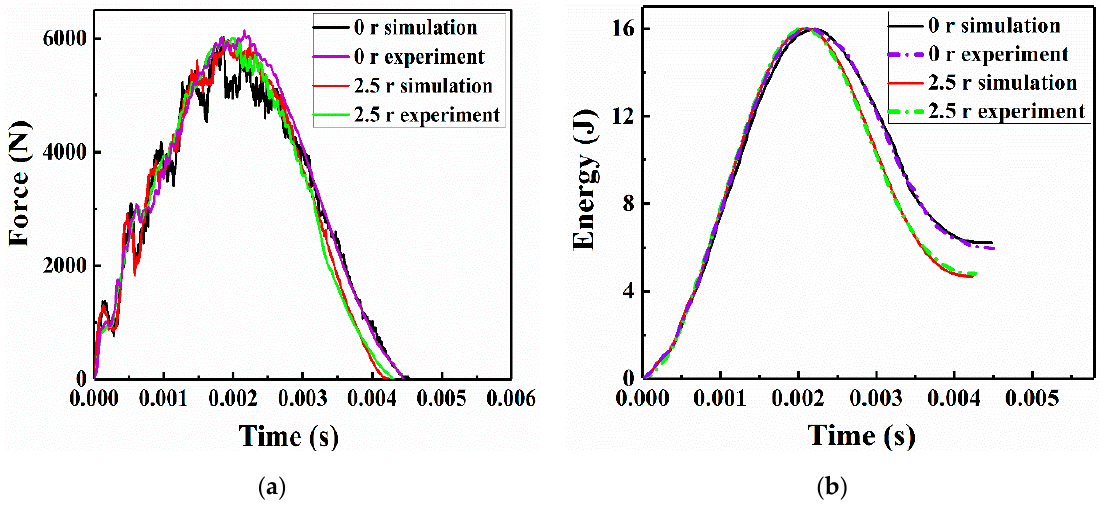
Figure 8. Numerical and experimental results of the specimens repaired with patches of radii 0 r and 2.5 r: ( a ) impact force and ( b ) absorbed energy.